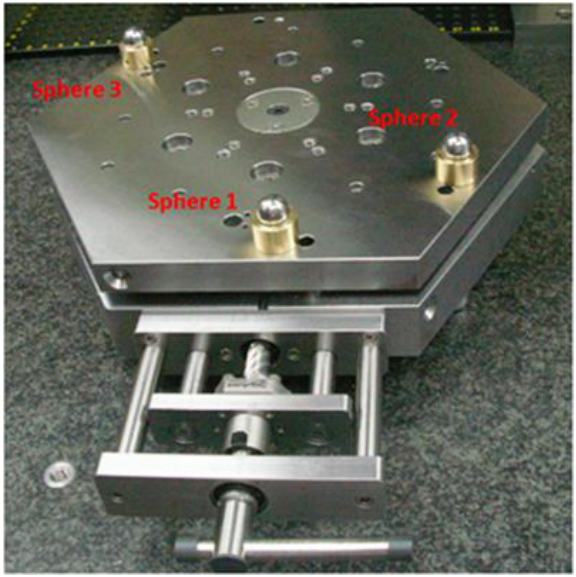
Figure 16. Spheres on upper platform to evaluate the mechanical repeatability of the IMP.